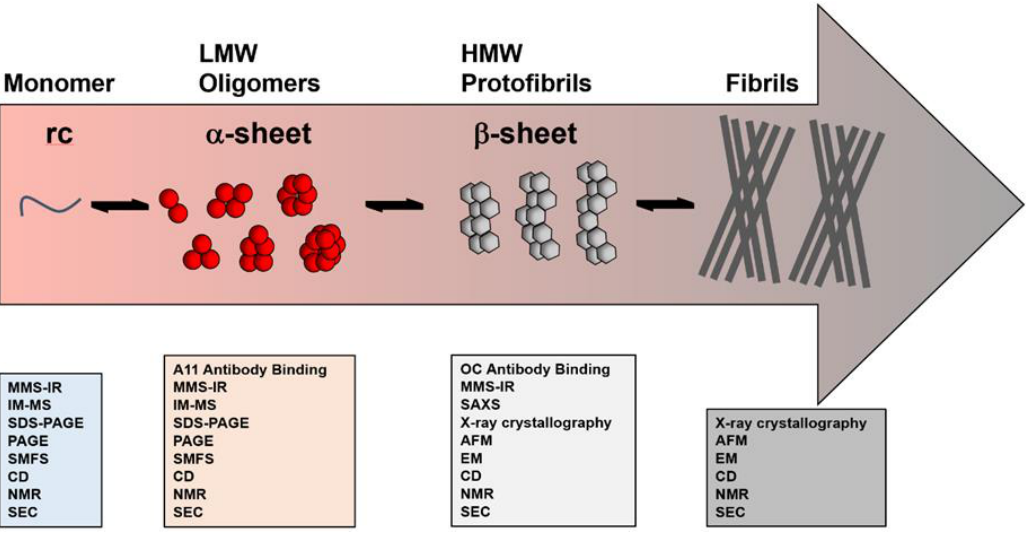
Figure 1. Pathology of disease progression and characterization techniques. Low molecular weight aggregates are soluble and contain primarily α -sheet structure that have been characterized by size and structure by the associated techniques. High molecular weight aggregates are soluble but contain primarily β -sheet structure that can be characterized by the associated techniques.